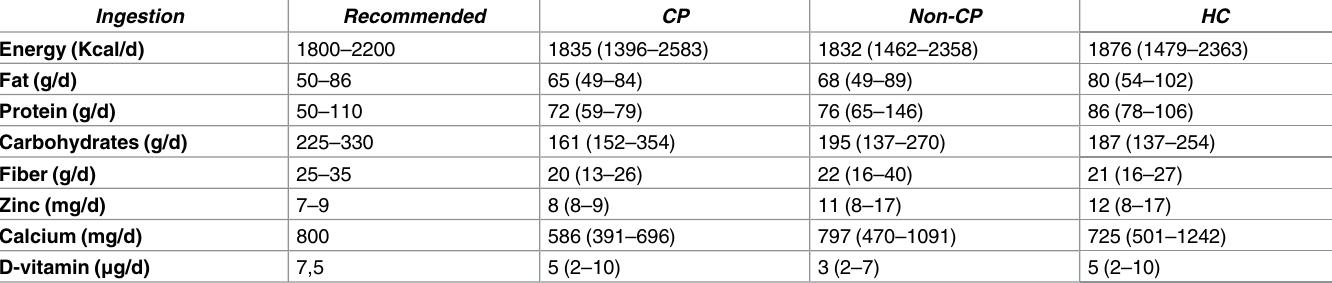
Fecal fat parameters related to EPI standard Using cut-off for bicarbonate concentration of 80mmol/l as standard, we drew ROC curves for fecal elastase and the two fecal fat parameters (Fig 4). Data for diagnostic accuracy are pre- sented for the respective parameters in Table 3. The ROC curves displayed no significant dif- ference in diagnostic performance between the chosen parameters for the PEI standard. Table 2. Nutrition